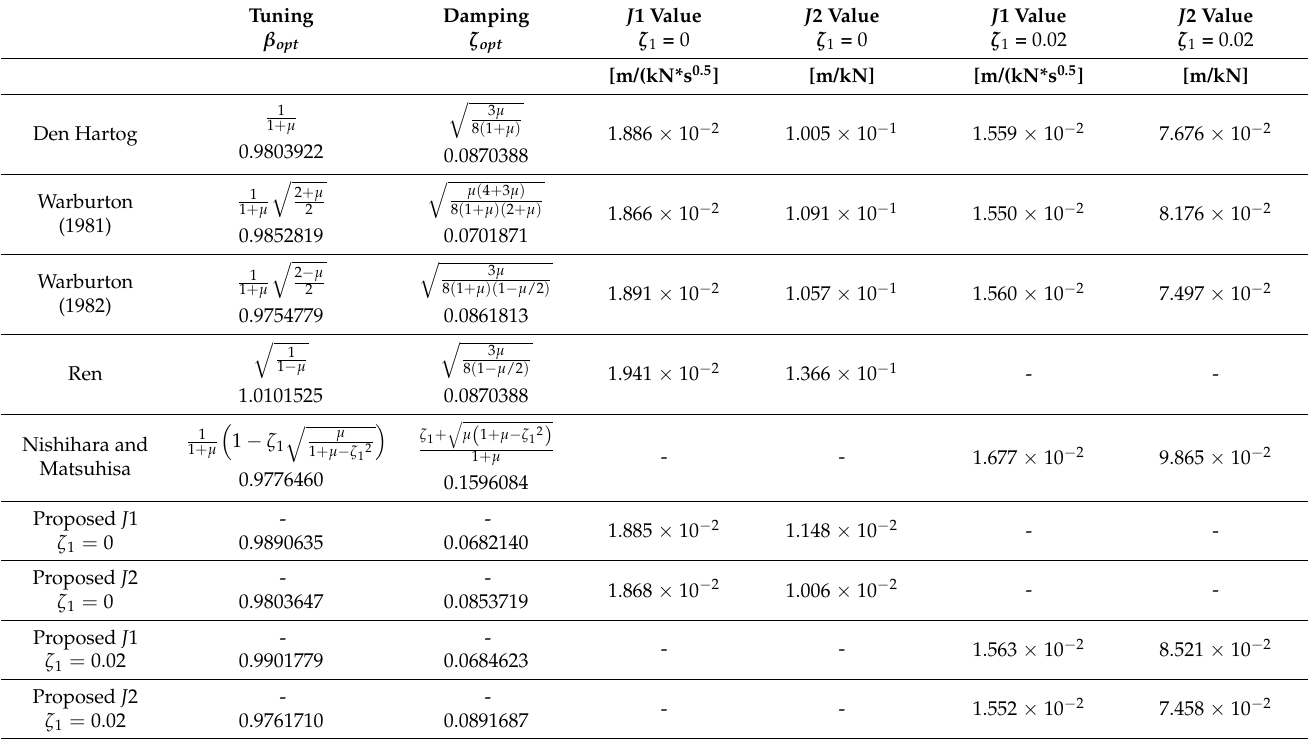
Table 5. Optimal parameters and J 1 and J 2 objective function values for 1TMD, based on various authors (values for µ =